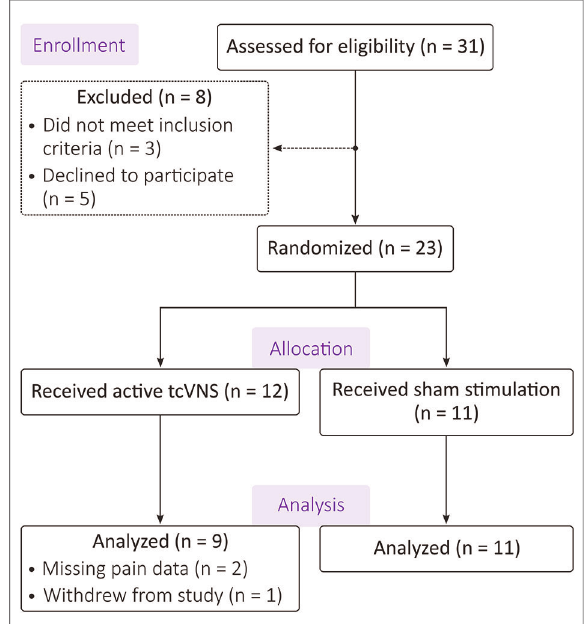
FIGURE 2 CONSORT diagram. Of the 31 patients assessed for eligibility, 8 patients were excluded or declined to participate. The remaining 23 patients were randomized to exclusively receive either active transcutaneous cervical vagus nerve stimulation (tcVNS) or sham stimulation. Two participants ’ data in the active group were unusable due to equipment malfunctions. An additional participant from the active group withdrew from the study. The analysis thus included data from 9 patients in the active group and 11 patients in the sham